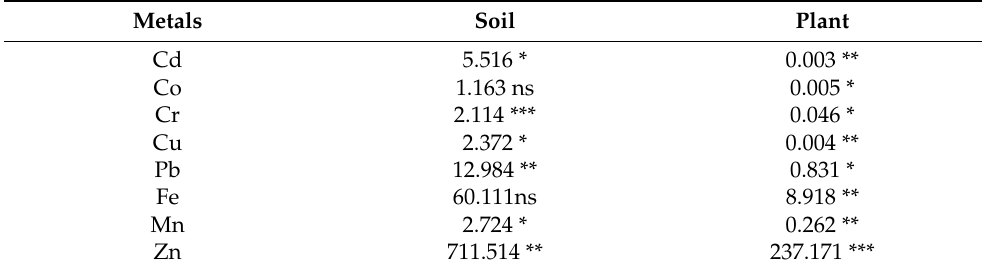
Table 2. Analysis of variance ( p values) of heavy metal concentrations in soil and A.